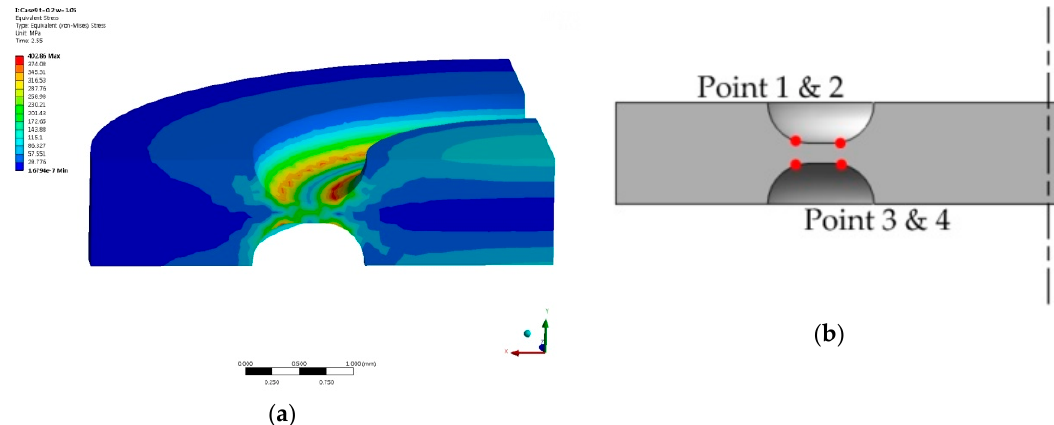
Figure 9. Analysis results at t = 0.2 mm, w = 1.05 mm, P = 12.5 MPa: ( a ) stress distribution; ( b ) yield points. For t = 0.2 mm, the flat type has a yielding pressure around at 3.55 MPa, which is much lower than the round-grooved type at 13.75 MPa or the square-grooved type at 5.87 MPa. For t = 0.3 mm,